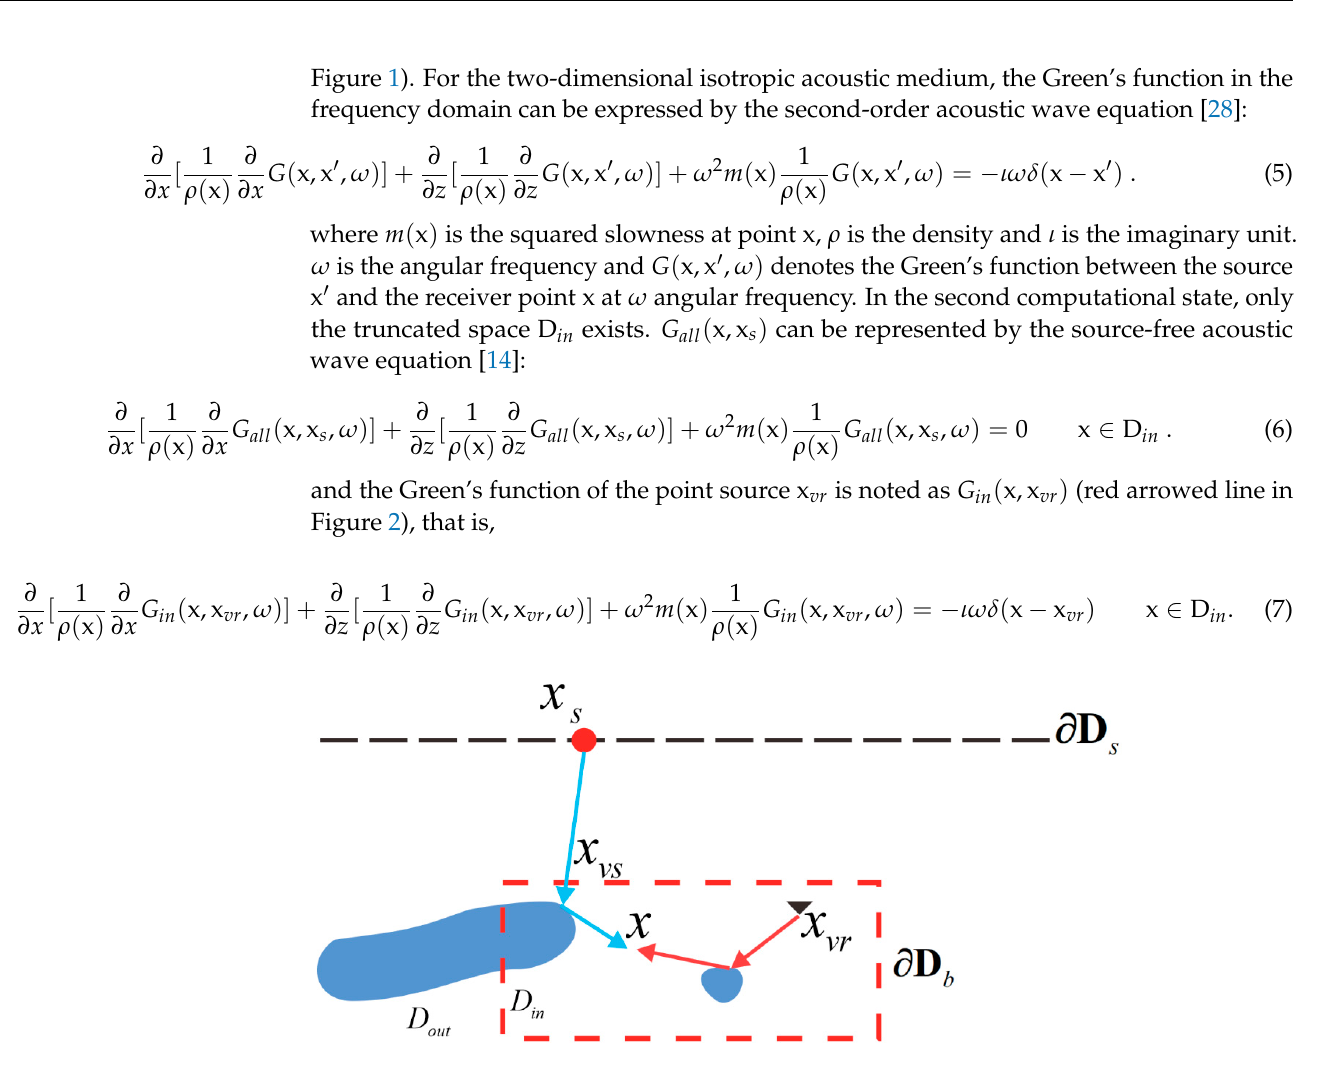
Figure 1. Schematic of Green’s function in different computational states. Blue arrows mean the Green’s function between the surface source x s and a point in the target area x in the medium state of the full-domain model. Red arrows mean the Green’s function between x and a virtual receiver x vr in the truncated medium state. The surface is represented as the black dashed line D s ∂ . The dashed rectangular box D b ∂ is the boundary of the target. D in is the internal region of the target zone, D out is the external region. The first computational state is the complete model, containing D in and D out . The second computational space is a truncated medium with D in only. Under (x,x ) all s G (blue arrowed